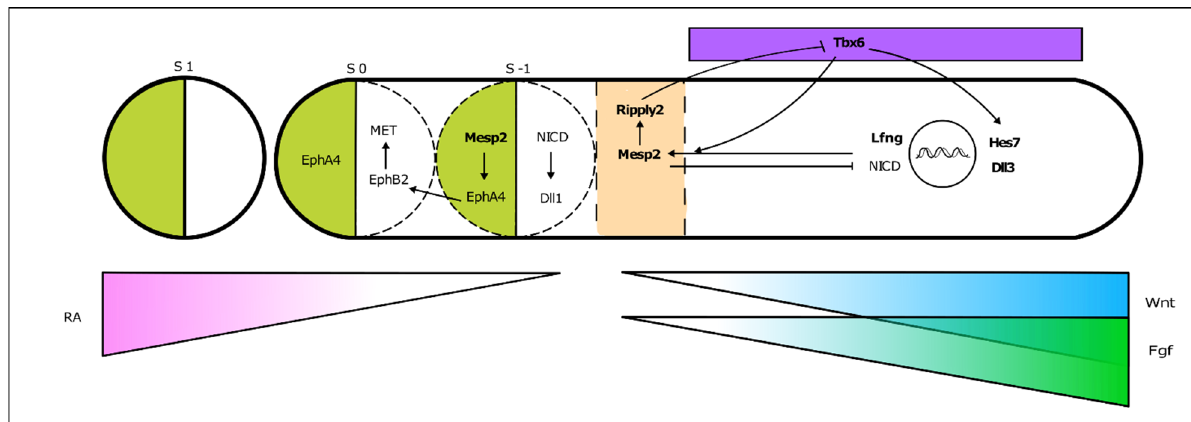
Figure 4. From somitogenesis clock oscillations to somite boundary formation. Periodic activation of Mesp2 at the rostral PSM, where FGF signaling is greatly decreased, triggers a molecular cascade ultimately leading to the budding off of a new somite. This is a simplified schematic representation, where the identified mutated genes in SCDO are highlighted.